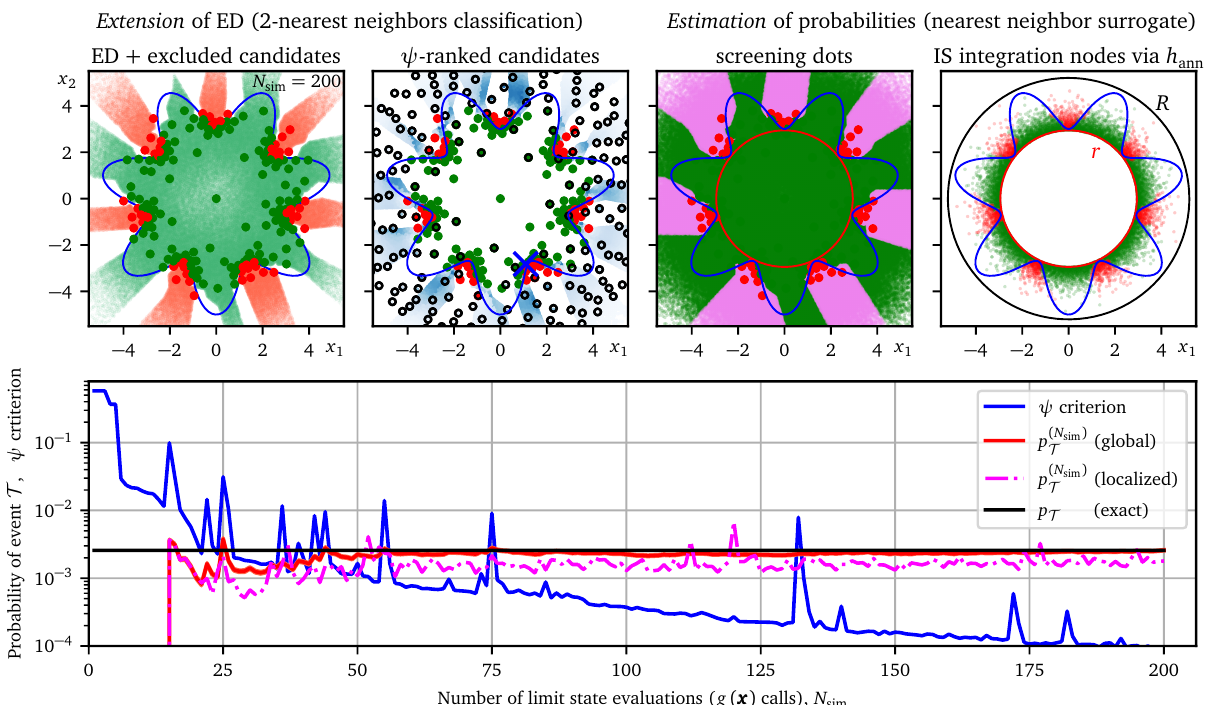
Figure 3. Top row: on-the-fly classification of territories. Two top left panels: two nearest neighbors for the classification of boundary regions – red and white candidates are censored out, and the retained (blue) candidates are considered for the extension of ED. Two top right panels: classification of dots and nodes via the nearest neighbor. Bottom: history of the failure probability estimation and the ψ criterion quantifying the approximate ”probability bites” by selected candidates. The complete evolution of all panels is demonstrated in the Wavy circle video